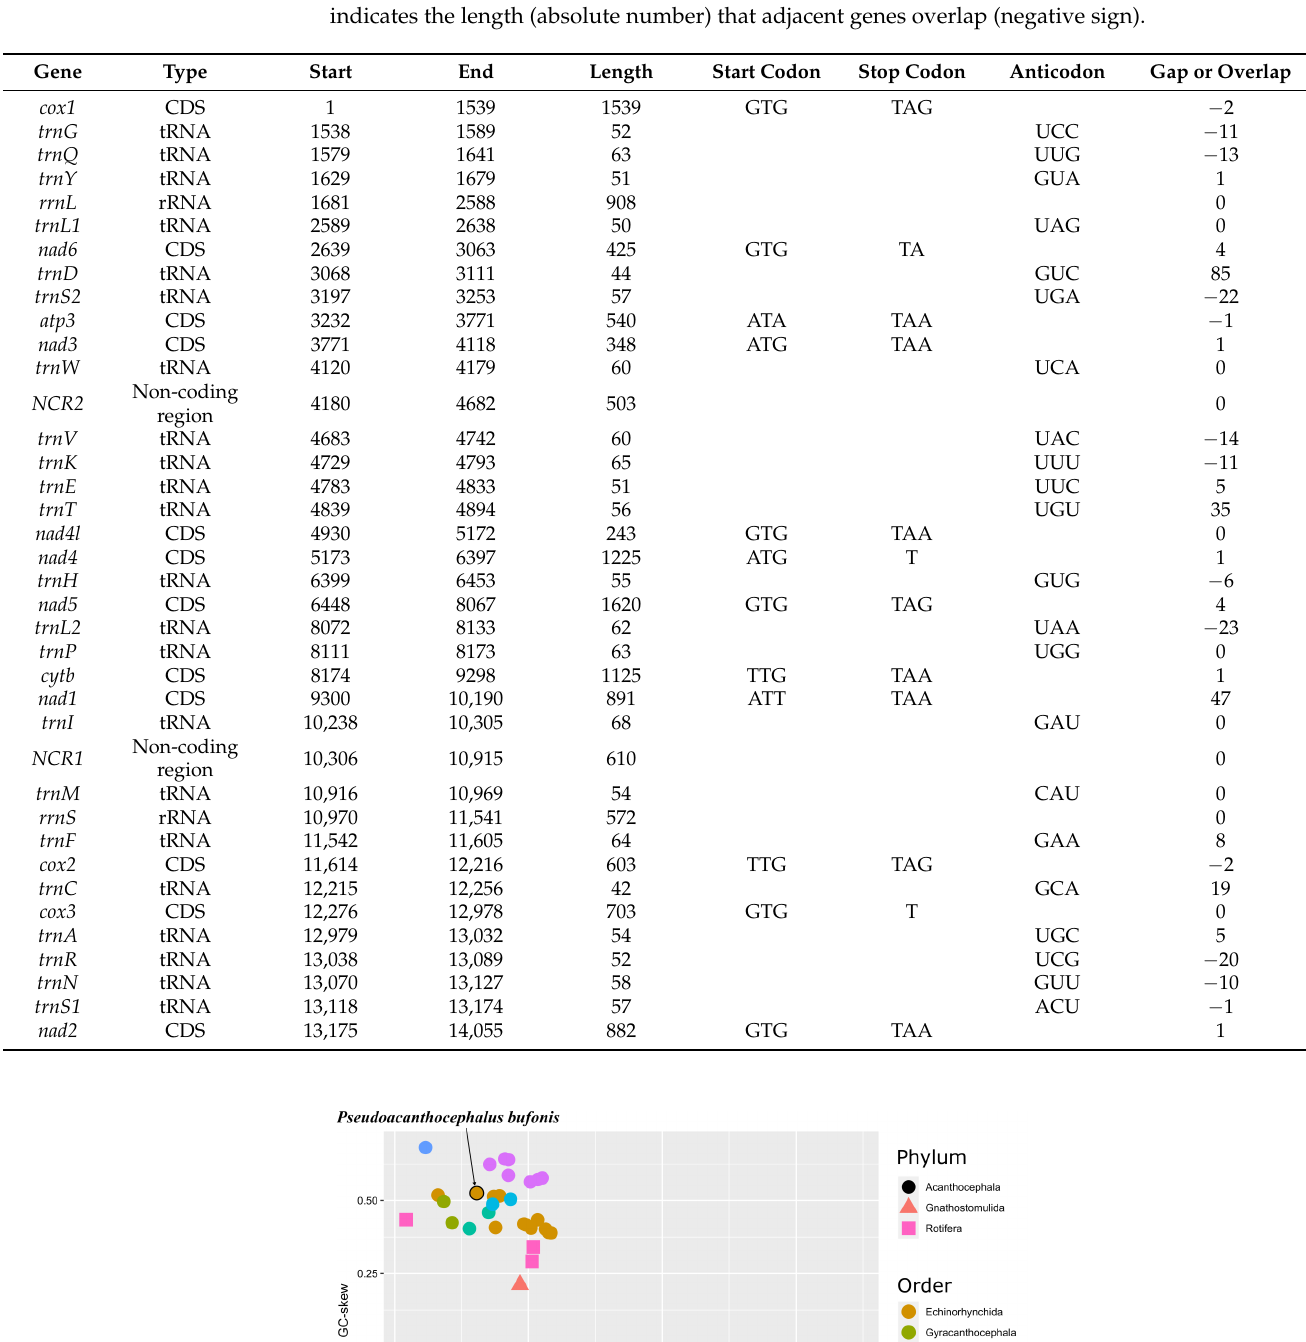
Table 4. Annotations and gene organization of Pseudoacanthocephalus bufonis . The positive number in the “Gap or overlap” column indicates the length of intergenic sequence, and the negative number indicates the length (absolute number) that adjacent genes overlap (negative sign).